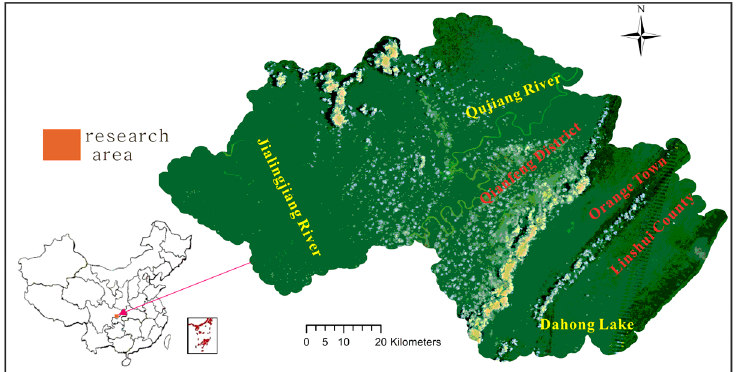
Figure 1. Administrative map of Guang’an city.